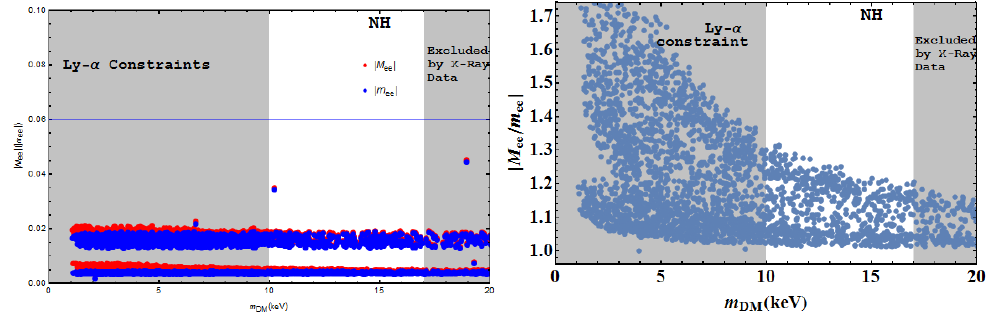
Figure 16 . Preictoions of e(cid:11)ective mass as a function of m DM for normal hierarchy. The standard contribution is shown in blue color and nonstandard contributions with pseudo-Dirac neutrinos and sterile state are shown in red color. Comparison of these two contributions are shown in the (cid:12)gure on the right side.